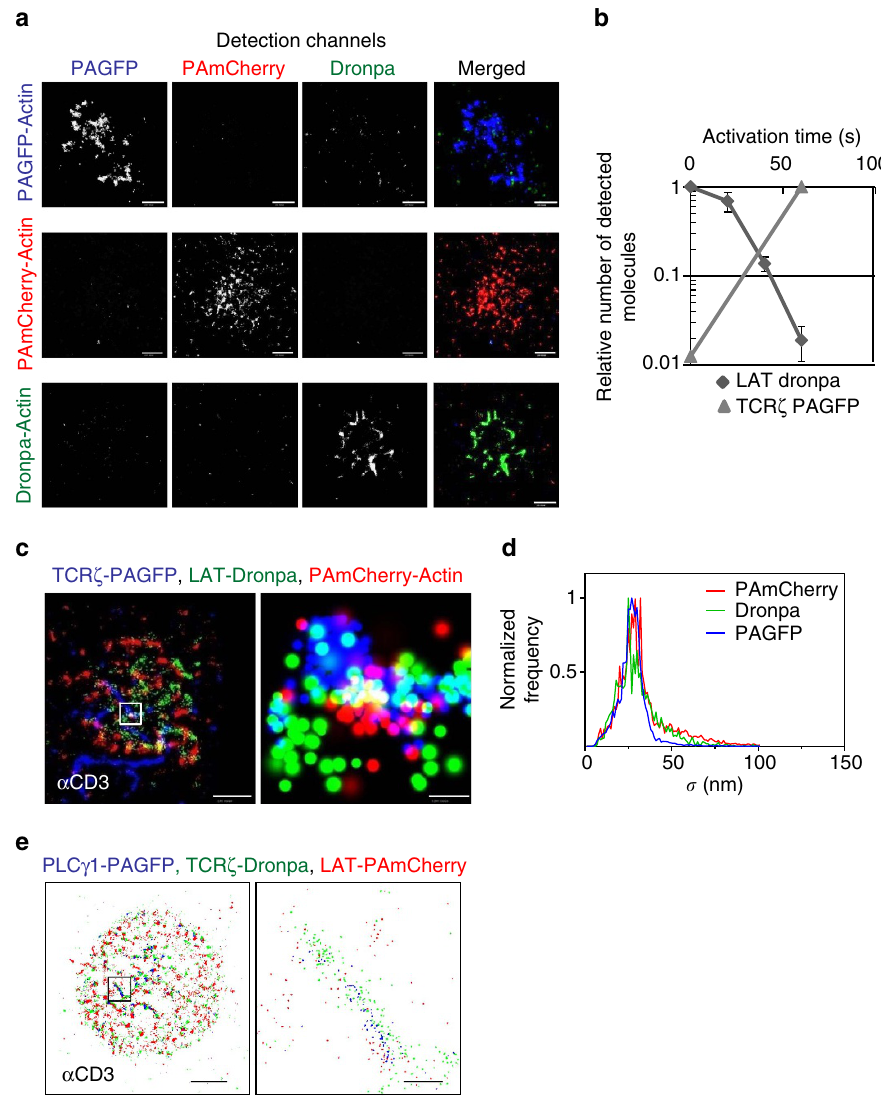
Figure 1 | MC-PALM imaging of fixed and live Tcells. ( a ) Multicolour PALM (MC-PALM) imaging of fixed E6.1 Jurkat cells expressing actin tagged with either PAGFP, Dronpa or PAmCherry, spread on an a CD3-coated coverslips for 3min before fixation. For each construct, images are shown for the PAGFP (blue), PAmCherry (red) and Dronpa (green) channels separately and combined to show the extent of cross-talk between the channels. Maximal probability density values for PAGFP, Dronpa and PAmCherry rendering (see Supplementary Information for further details)—( a ) 220, 50, 270 molecules per m m 2 (top row); 140, 80, 90 molecules per m m 2 (middle row); and 410, 450, 700 molecules per m m 2 (bottom row), respectively. Scale bars, 2 m m. ( b ) The relative number of detected molecules of either LAT-Dronpa or TCR z -PAGFP as a function of photoactivation dose, showing the cross-talk between the Dronpa and PAGFP channels in MC-PALM. ( c ) MC-PALM imaging of fixed Jurkat cells expressing TCR z -PAGFP, LAT-Dronpa and PAmCherry-actin, spread on an a CD3-coated coverslips for 3min before fixation. Maximal probability density values for PAGFP, Dronpa and PAmCherry rendering 260, 220, 220 molecules per m m 2 . Scale bar, 2 m m (left); and 200nm (right). ( d ) The distribution of error (1 s ) in localization of individual PAGFP, PAmCherry and Dronpa molecules imaged via MC- PALM. ( e ) MC-PALM of a live Jurkat E6.1 cell expressing PLC g 1-PAGFP, TCR z -Dronpa and LAT-PAmCherry on an a CD3-coated coverslip. Scale bar, 2 m m (left); and 200nm ( G , B and R in Fig. 2b). In each binary image, a disk with a Supplementary Information). The distance transform labels each diameter equivalent to 20 nm marked the positions of individual pixel of the image with the distance to the nearest boundary molecules (see consideration for choosing the disk size in the pixel in a binary image (here, the boundary is the edge of Analyses section of Supplementary Information). The intensity the cluster that contains the pixel). In the resultant watershed or inside a disk was set to 1, while areas outside disks without topographical image ( G DT ) intensities are highest at points molecules were assigned a value of 0. In areas where disks furthest from the boundaries in the binary image. Finally, overlapped, the intensity remained 1. We then used a distance weighted images were produced by multiplying each binary image transform 25 of the binary image (or actually, its negative) to form (namely G , B and R ) by the watershed image G DT (Fig. 2c, three a topographic map of LAT complexes from the LAT channel right images labelled G (cid:2) G DT , B (cid:2) G DT and R (cid:2) G DT ). We also developed a measure we call the ‘localization topology’ (Fig. 2c, lower left panel and its inset; see definitions in equations to quantify the extent to which other proteins are recruited to the (1) and (2) and further details in the Analyses section of